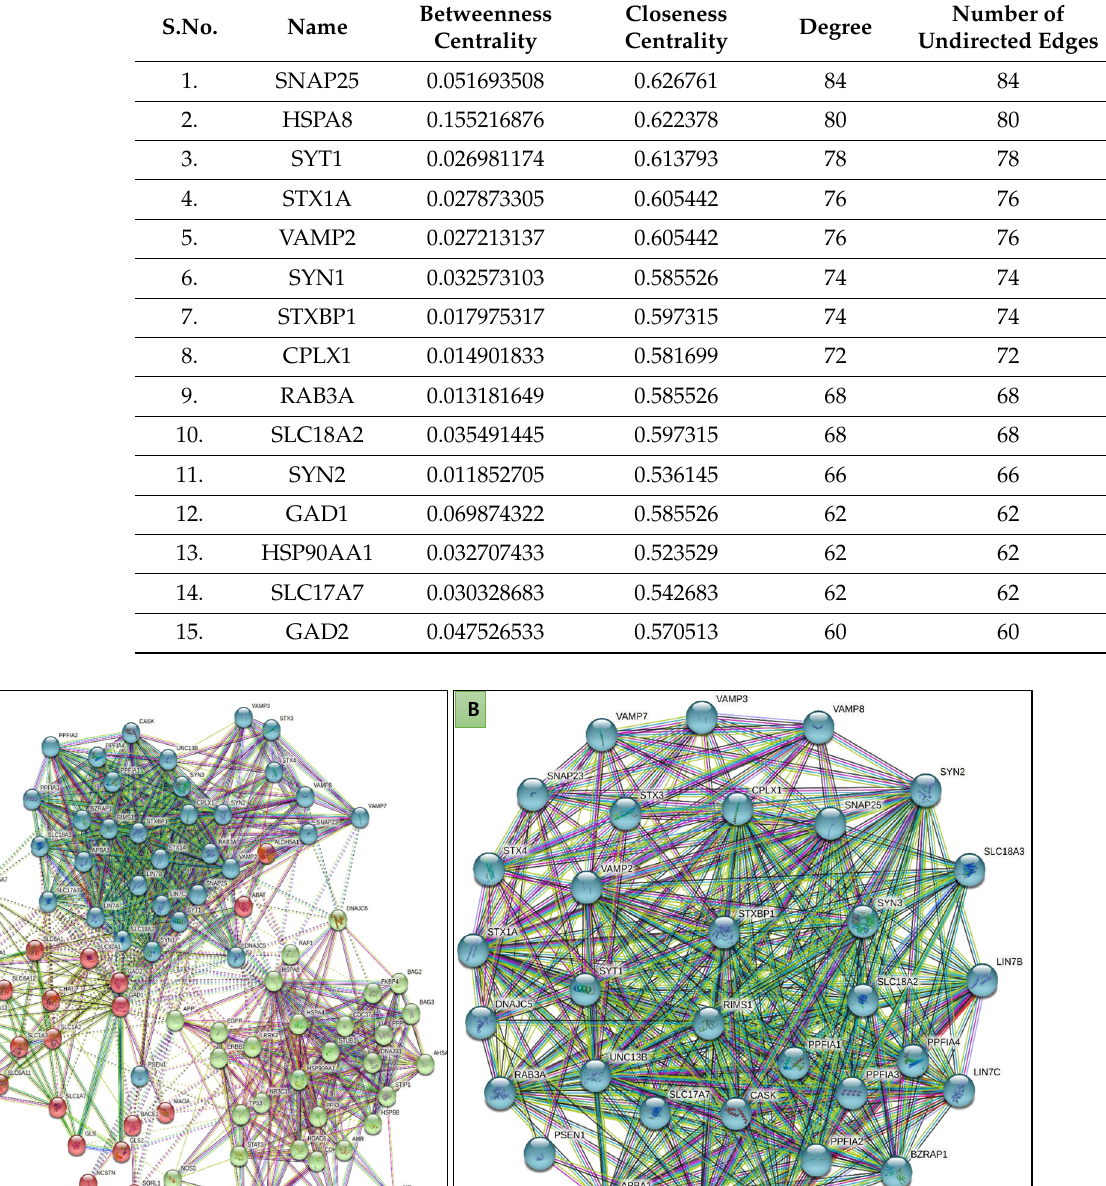
Table 1. Betweenness Centrality and Closeness Centrality of the 15 selected genes.